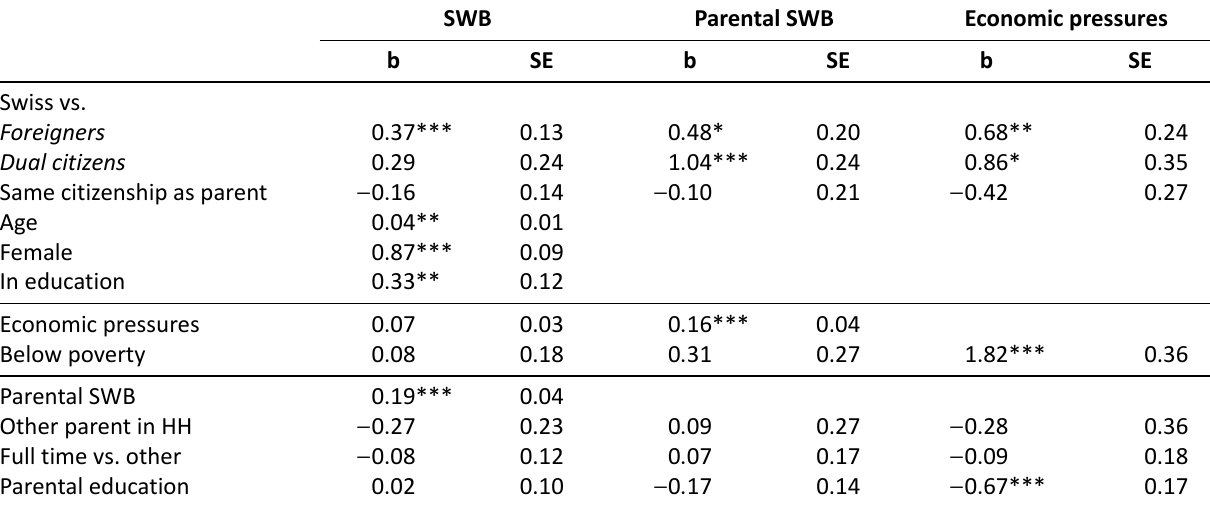
Table 3. Results of path model (respondents and their fathers).